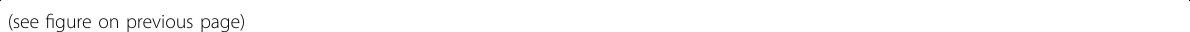
Fig. 5 The de fi ciency of DRD5 signaling increased colonic M1 macrophages but reduced M2 cells in the colon of DSS colitis mice. A Immuno fl uorescent labeling of F4/80 + , Arg1 + , and Inos + colonic macrophages of WT and DRD5 − / − mice on day 6 after DSS treatment (top). The cell numbers are quanti fi ed by Image pro plus (bottom) ( n = 3). Scale bars, 200 μ m. B Flow cytometry analysis of colonic macrophages of WT and DRD5 − / − mice ( n = 5 mice per group) on day 6 after DSS treatment as indicated. Data are presented as representative plots (top) and summary graphs of quanti fi ed percentages (bottom). C Flow cytometry analysis of the CD45.2 + cells percentage in Arg1 + and CD86 + colonic macrophages of lethally irradiated mice reconstituted with DRD5 − / − CD45.2/WT CD45.1 bone marrow (1:1 ratio), and a control WT CD45.2/WT CD45.1 group (1:1 ratio) on day 6 after DSS treatment ( n = 3 mice per group). Data are presented as representative plots (left) and summary graphs of quanti fi ed percentages (right). Data are pooled from two or three independent experiments. Error bars show means ± SEM. * p < 0.05, **p < 0.01, *** p < 0.001. Two-tailed unpaired student ’ s t -test ( A , B , C